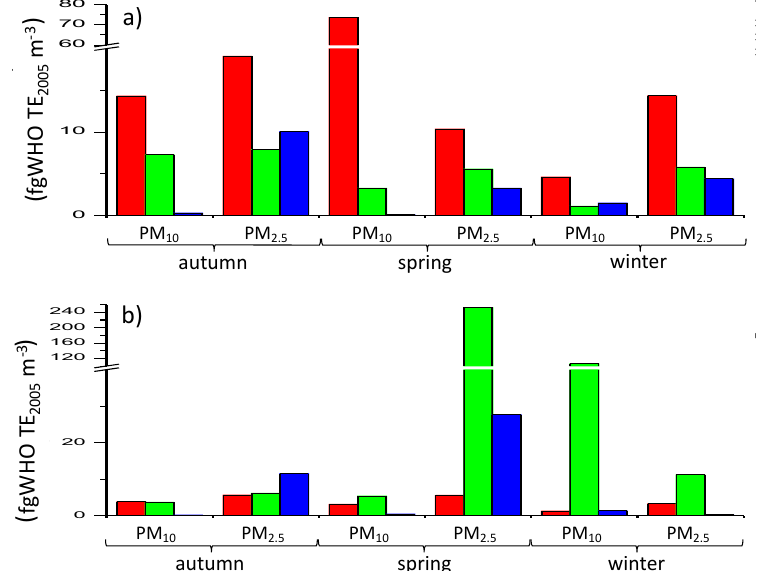
Figure 8. Polychlorinated dibenzodioxin and Polychlorinated dibenzofuran (PCDD/F) and Polychlorinated biphenyl (PCB) concentrations in ( a ) urban site and ( b ) suburban site—sector #3 shows during same monitoring period values greater or comparable with the other sectors suggesting a widespread contamination likely due to the presence of multiple emissive sources near the sampling site (red: sector #1; green: sector #2; blue: sector #3). Differently from PAHs, the lowest concentrations of PCDD/F not always are related to sector #3.